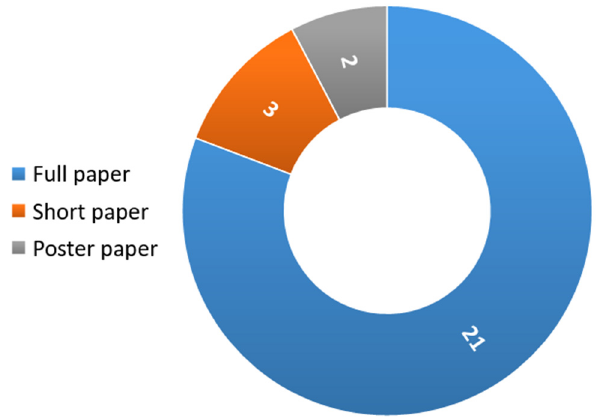
Figure 7. Number of papers by type.